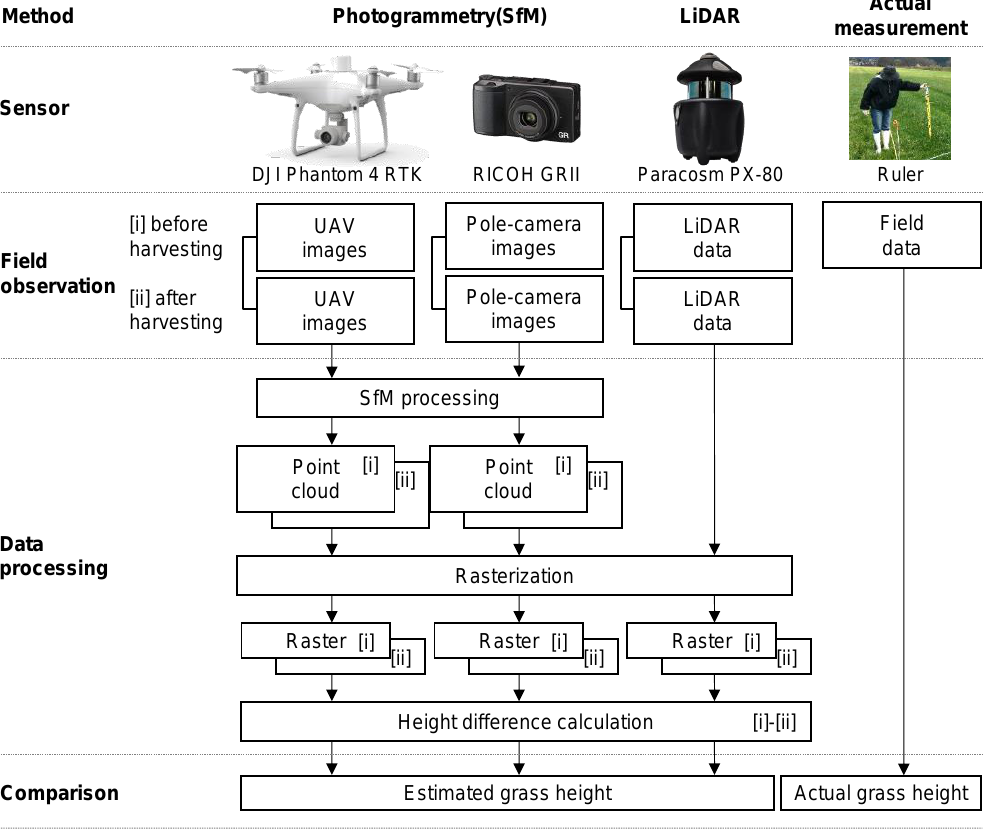
Figure 2. Outline of the measurement procedure.